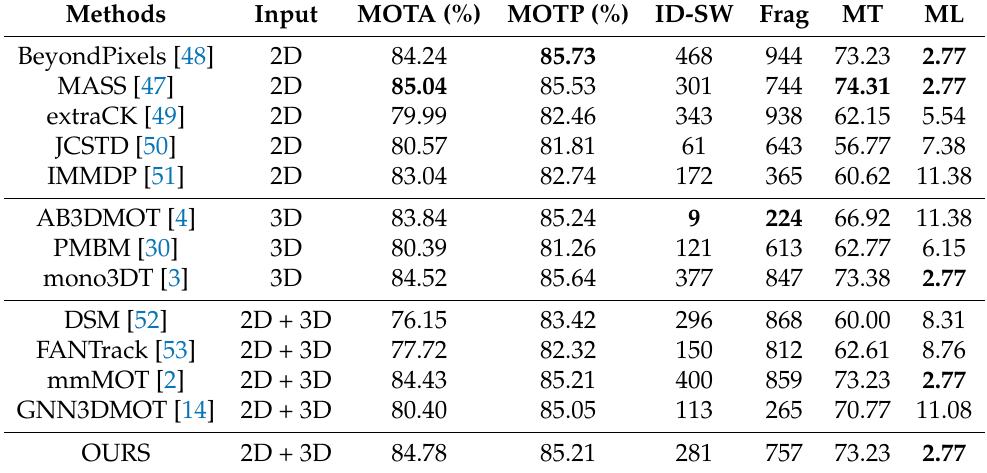
Table 1. 3D tracking results on KITTI tracking test set.